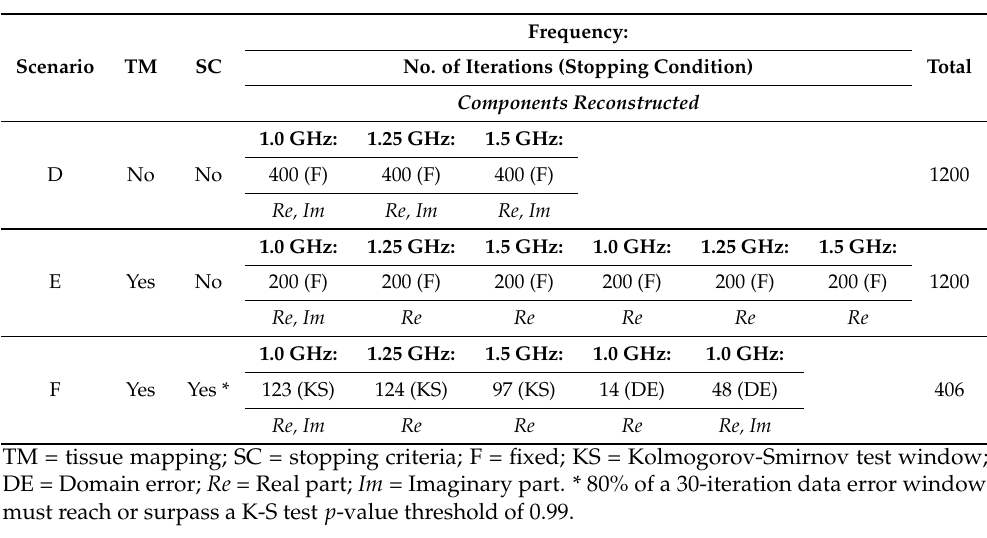
Table 2. Reconstruction progression of PEC-bounded scenarios (Figure 10).